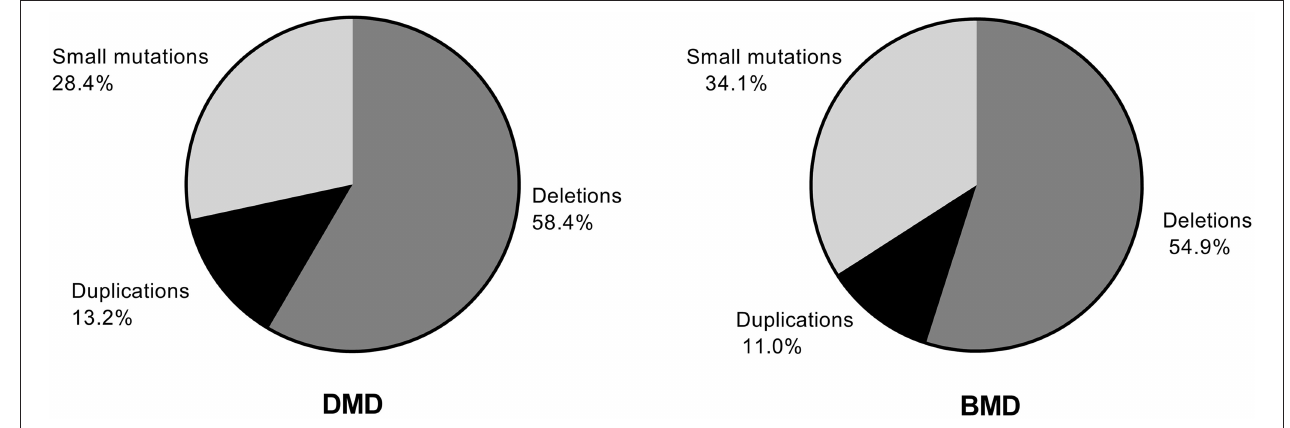
FIGURE 1 | Distribution of deletions, duplications, and small mutations in patients with Duchenne muscular dystrophy (DMD) and Becker muscular dystrophy